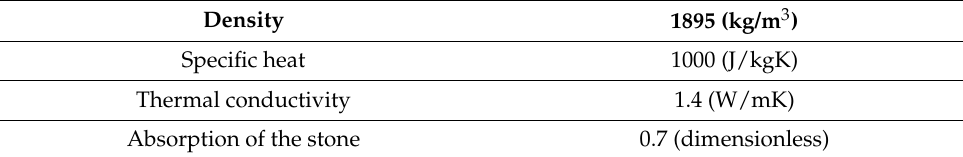
Table 3. Characteristics of stone of Girona and vaults [28].